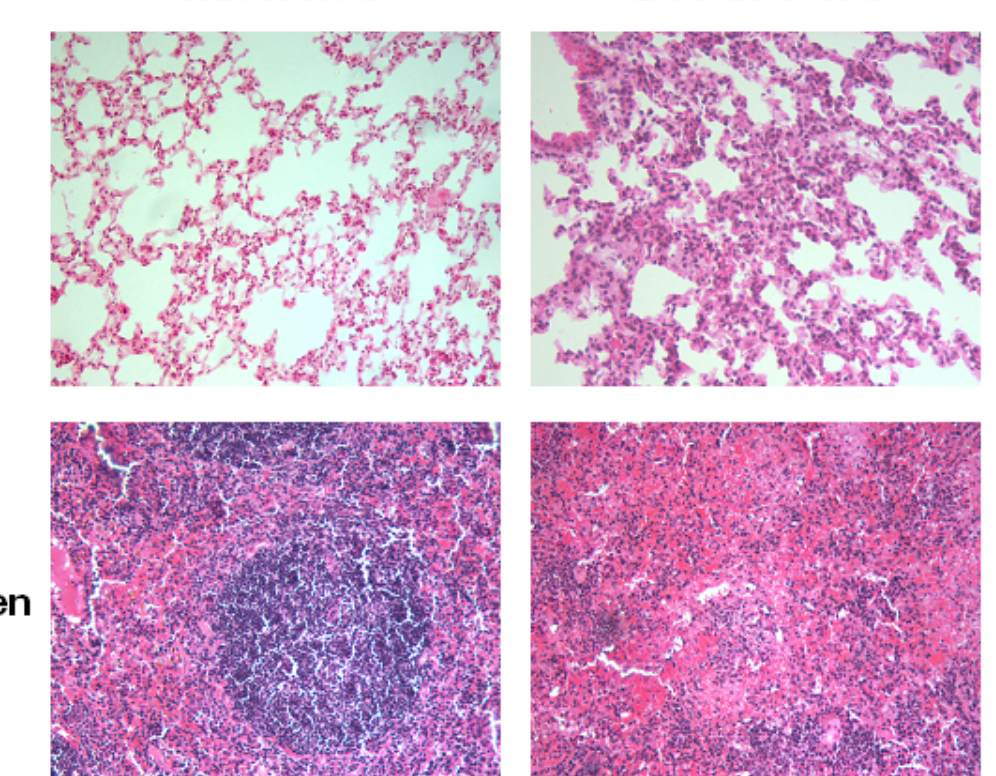
Figure 4. Tissue sections of lung and spleen from BTV-4 infected adult IFNAR ( 2 / 2 ) mice. Mice were infected with 10 3 PFUs of BTV-4 intravenously. Tissues were harvested at 48 h.p.i.. Hematoxylin and eosin staining are shown. Lungs of BTV-infected mice show hyperemia and increased size of the interalveolar septa (100 6 ). The spleen sections of BTV-infected mice show loss of architectural structure and marked lymphoid depletion (100 6